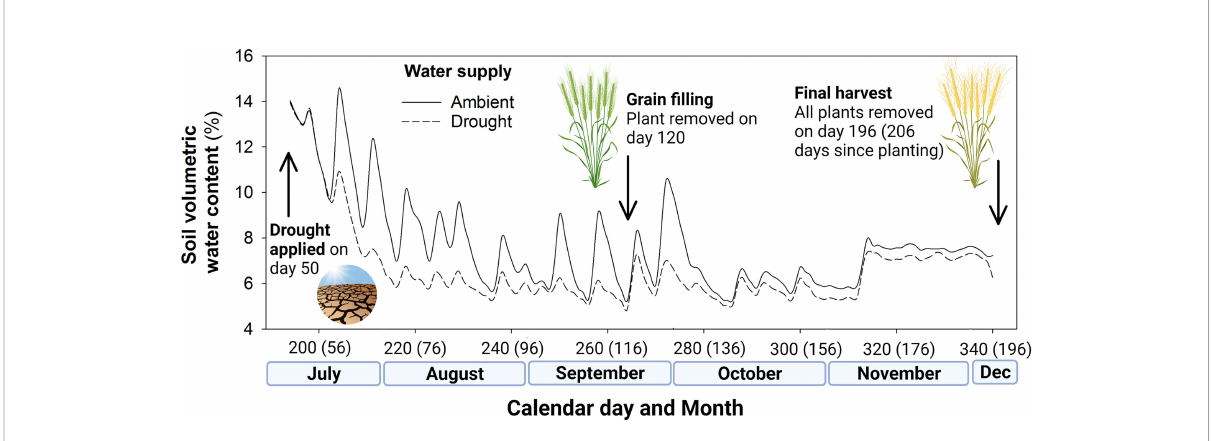
FIGURE 1 Soil volumetric water content (%) of the ambient well-watered plots and drought (50% rainfall reduction) treatment plots in the rain exclusion shelters, including key events of drought treatment application and the two harvests during the fi eld experiment. Days since seedling emergence given in